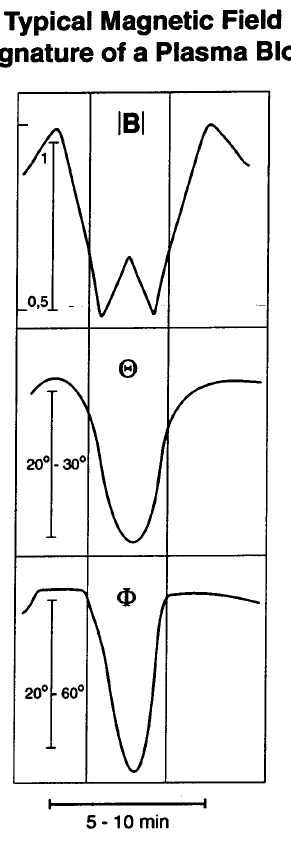
Fig. 7. Summary sketch of typical variations of B , theta and phi within a